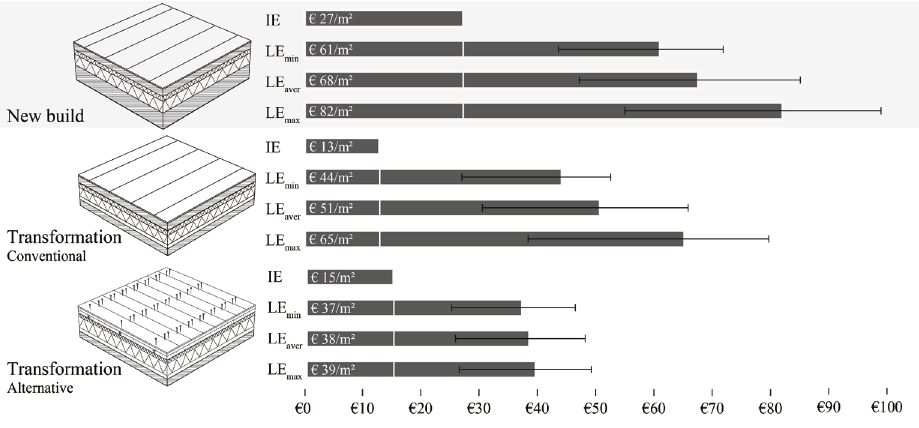
Figure 4. The outcomes of the environmental life cycle assessments of the ground floor show the gains of transforming compared to constructing a new equivalent element, regarding both initial and life cycle environmental impact, with IE as initial environmental impact, LE min as life cycle impact with no refurbishments, LE aver as life cycle impact with an average number of refurbishments, LE max as life cycle impact with a maximum number of refurbishments during 60 years. The error bars represent the results of the sensitivity analysis on a variable lifespan of the building (from 30 to 79